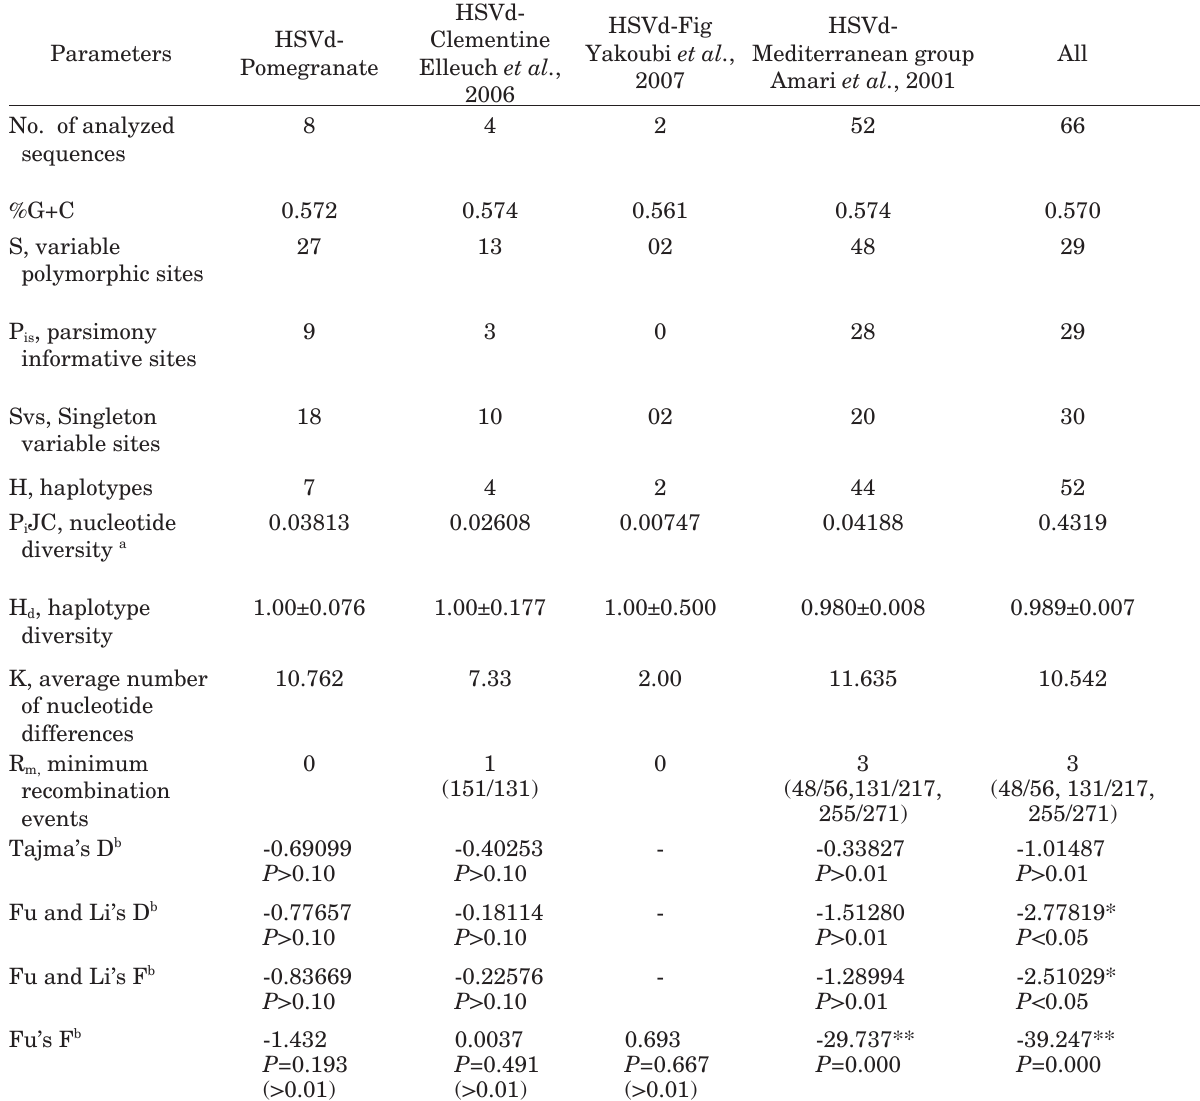
Table 3. Sequence polymorphism and divergence among Hop stunt viroid (HSVd) isolates from different hosts. Asterisks indicate that the test of Tajima and those of Fu and Li were negative and significant when all groups were